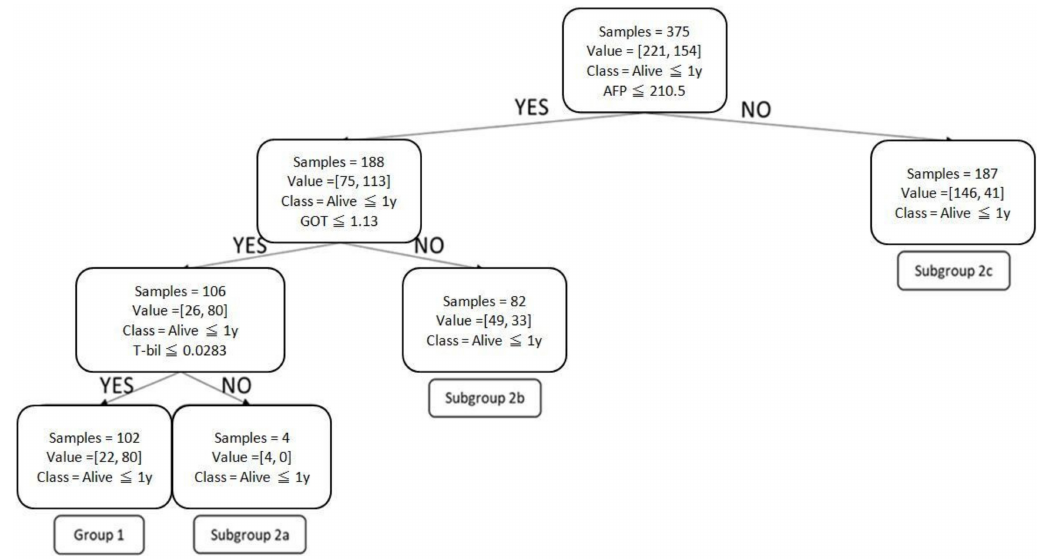
Figure 2. Post-pruning CART.